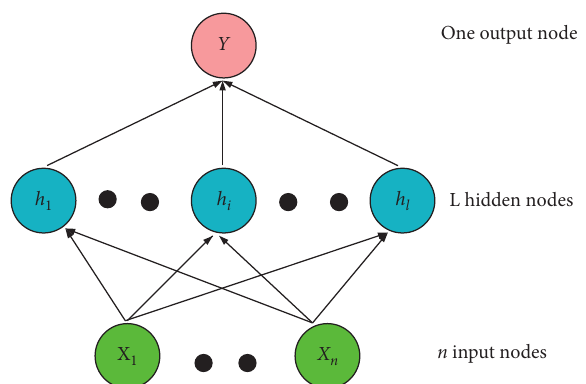
Figure 3: The topology diagram of the KELM